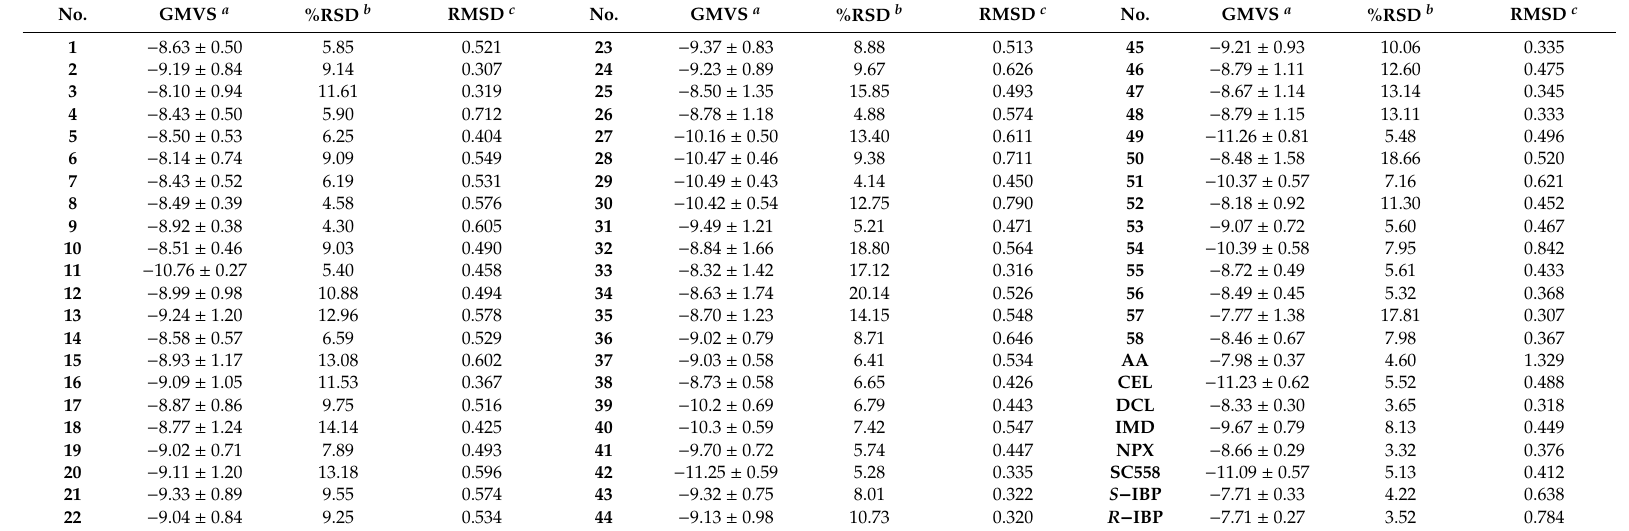
Table 2. Global mean values of Vina scores, relative standard deviation percentage (%RSD), and root mean square deviation (RMSD) (in Å) of 2-arylbenzofurans docked with cyclooxygenase-2 (COX-2)